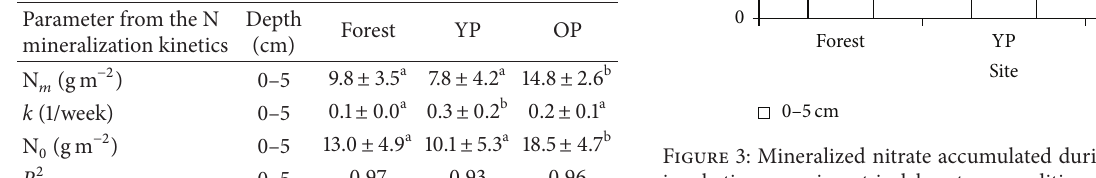
Table 8: Parameters derived from the N mineralization kinetics by applying the first-order equation N 𝑚 = N 0 [( 1 − exp −𝑘𝑡 )].